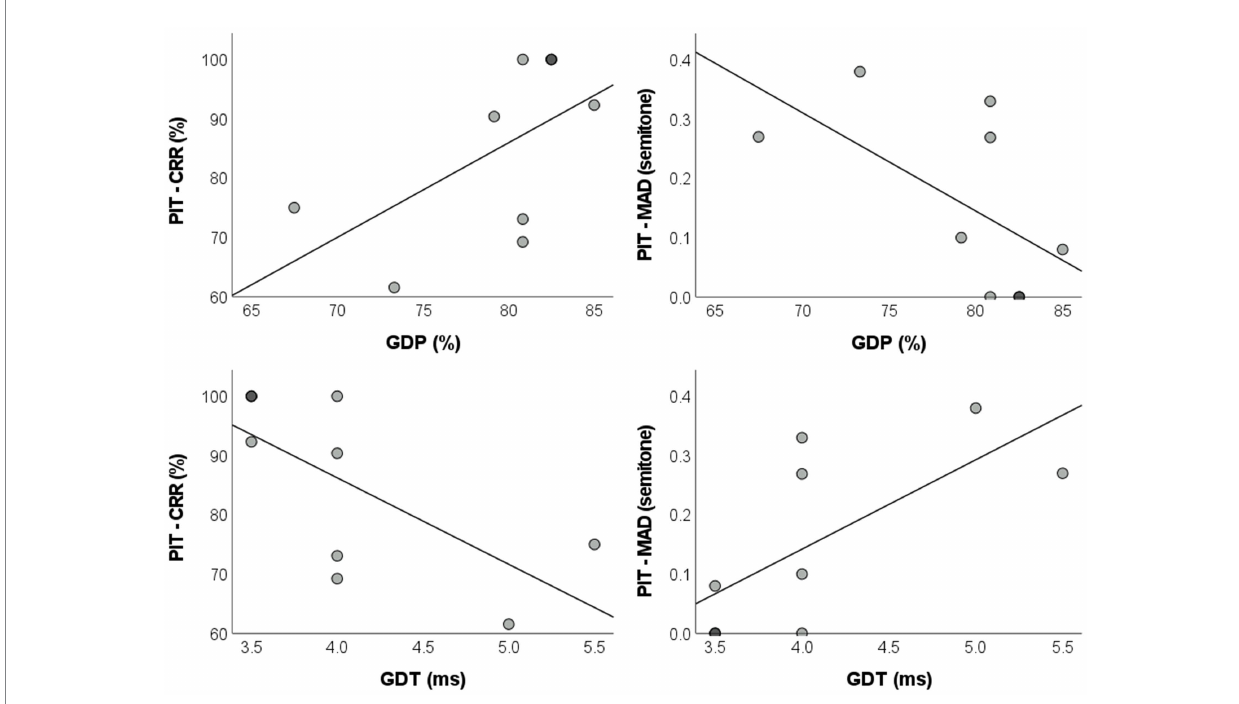
FIGURE 2 Dispersion plots with regression lines of the parameters for the pitch identification and GIN tests in the absolute pitch group. GIN: Gaps-in-Noise; GDP: gap detection percentage; GDT: gap detection threshold; PIT–CRR: pitch identification test–correct response rate; MAD: mean absolute deviation.